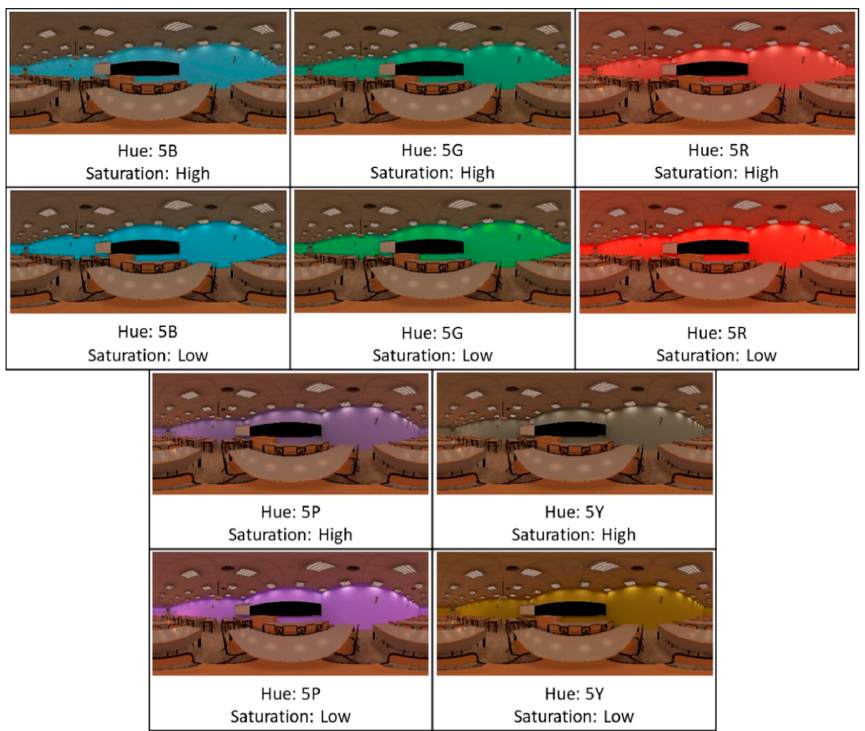
Figure 3. Virtual classrooms modified in colour.